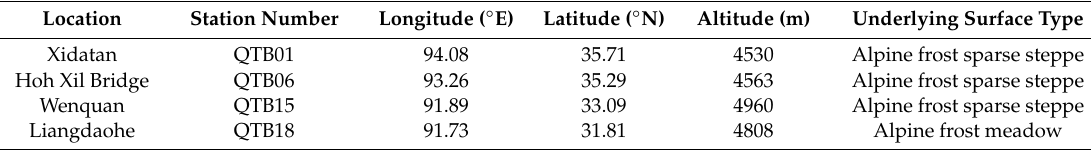
Table 2. The geographic information of the borehole observation